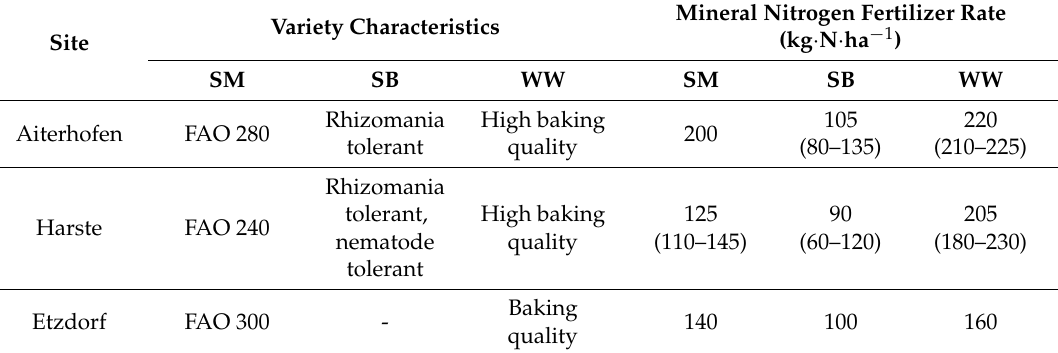
Table 4. Characteristics of cultivated varieties and mean (min-max) mineral nitrogen fertilizer rate of test crops silage maize (SM), sugar beet (SB) and winter wheat (WW) at three experimental sites in Germany